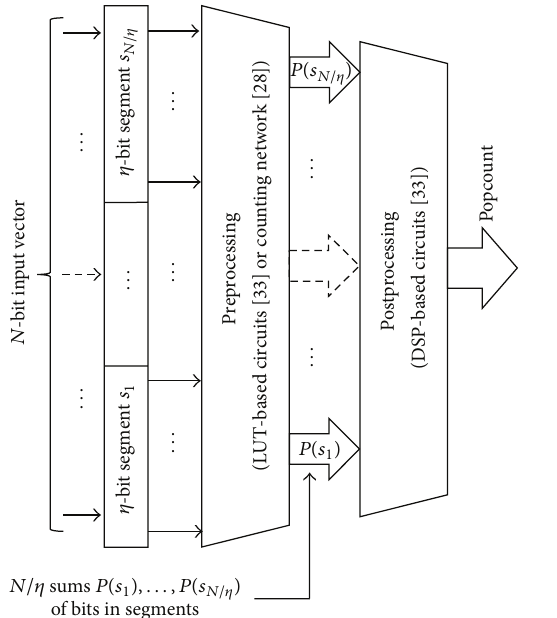
Figure 4: The proposed architecture for popcount computations in an FPGA-based accelerator.